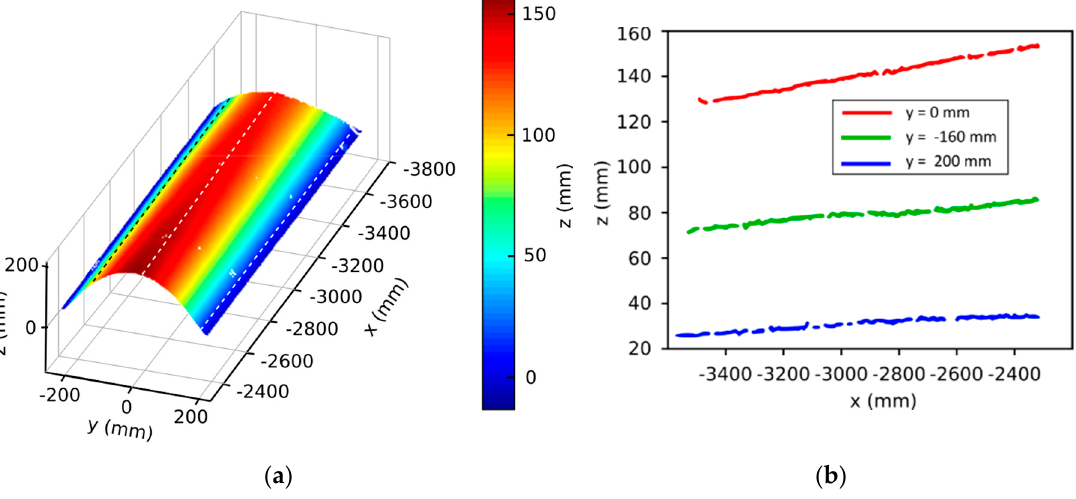
Figure 8. ( a ) Reconstruction of m-PTC without performing the vertical-parallax correction. ( b ) Section of the reconstructed profile for three different values of y , indicated by dashed lines in ( a ).